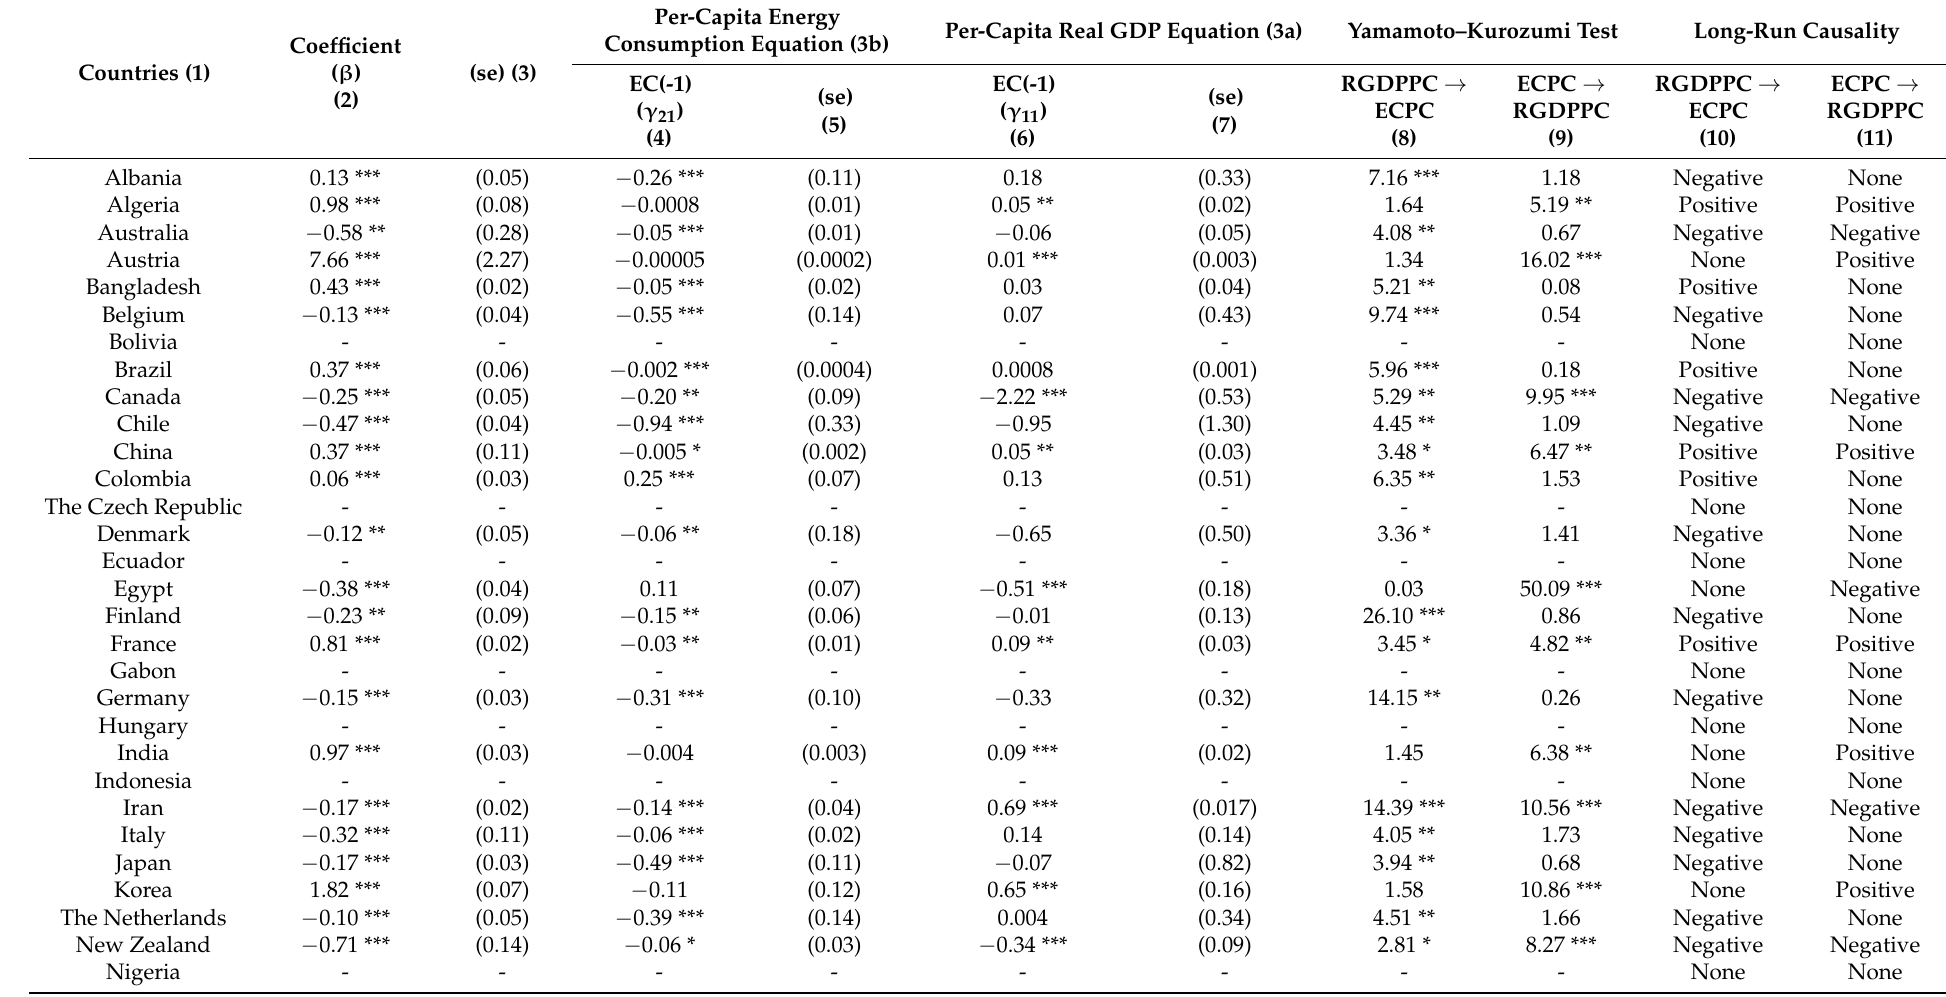
Table 2. Long-run causal